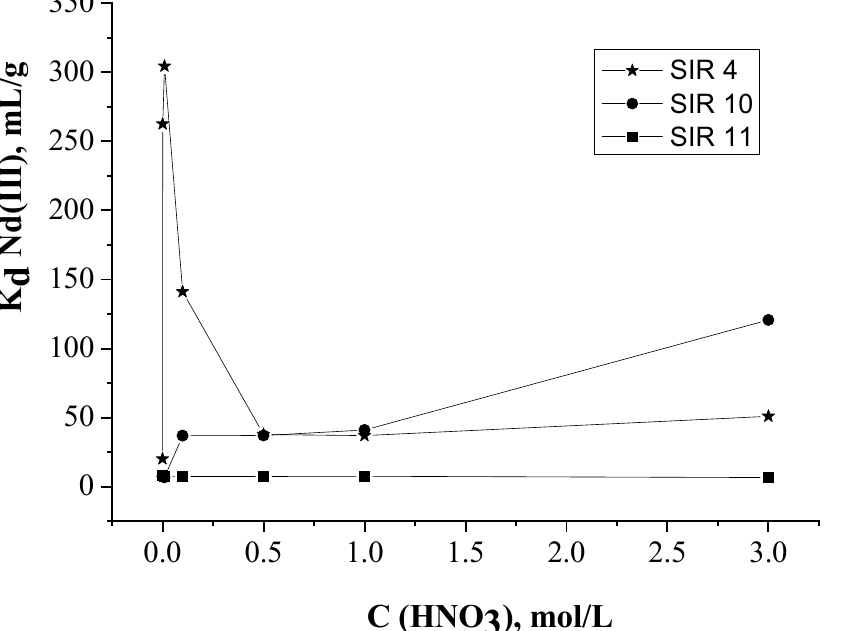
Figure 2. The influence of HNO 3 concentration on the value of distribution coefficient of Nd(III). Recently, we have studied the liquid-liquid extraction of REEs by mixture of (2-((diphenylphosphoryl)methoxy)phenyl)diphenylphosphine oxide L 1 (a structural analog of L, Figure 1) and ionic liquid [C 4 mim] + [Tf 2 N] − from nitric acid solutions [33]. It was estab-